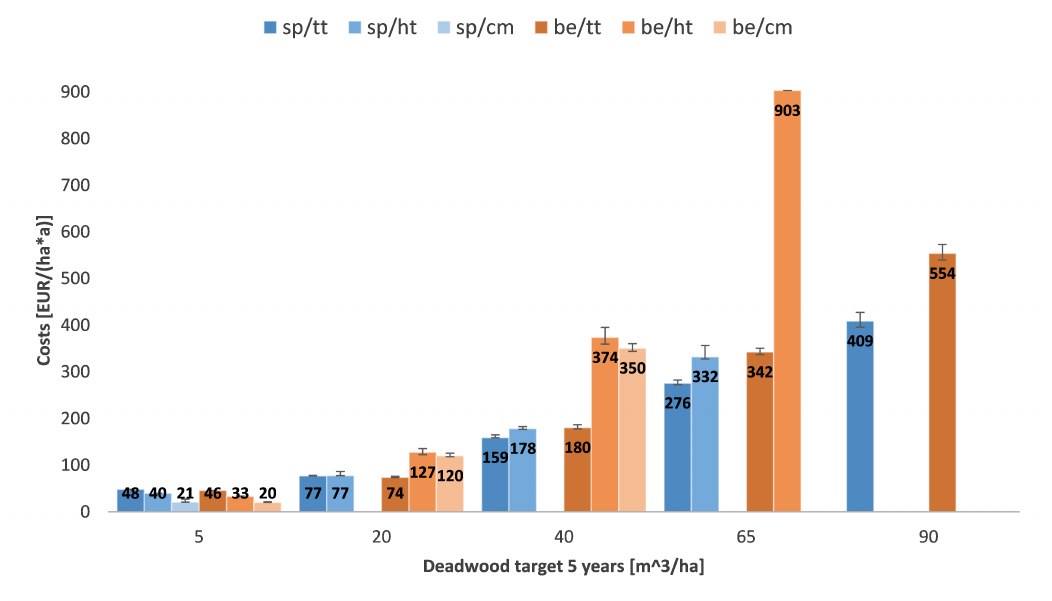
Figure 1. Forest enterprise “Eichelberg”: Costs in [ e ha − 1 a − 1 ] for target deadwood amounts in [m 3 ha − 1 ], to be maintained within 5 years. Blue columns show spruce ( sp ) and orange beech strategies ( be ). tt : Total tree, ht : Heavy timber, cm : Crown